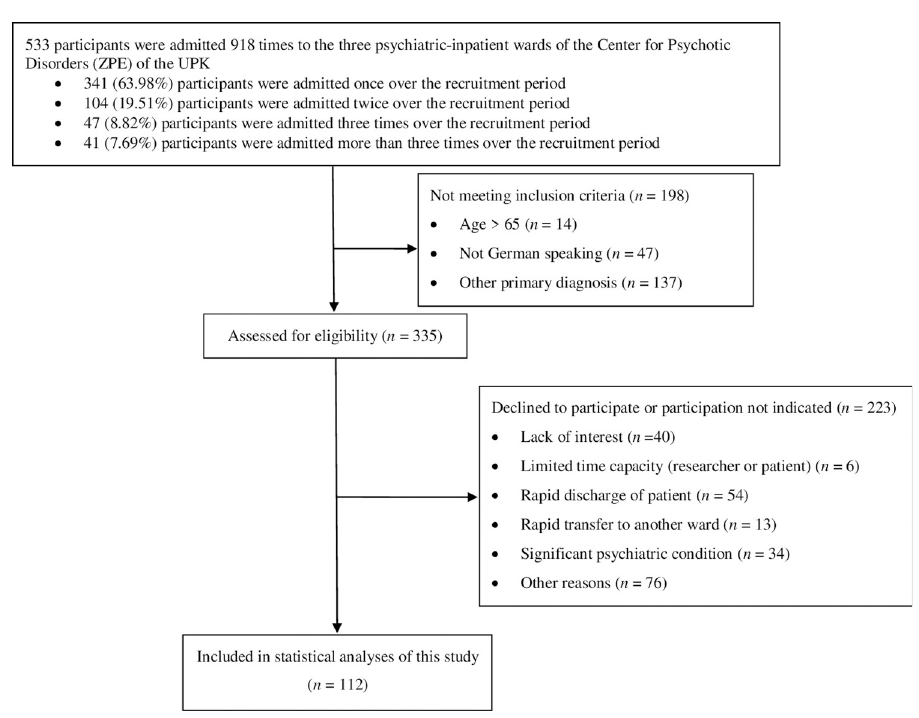
Fig 1. Flowchart of study